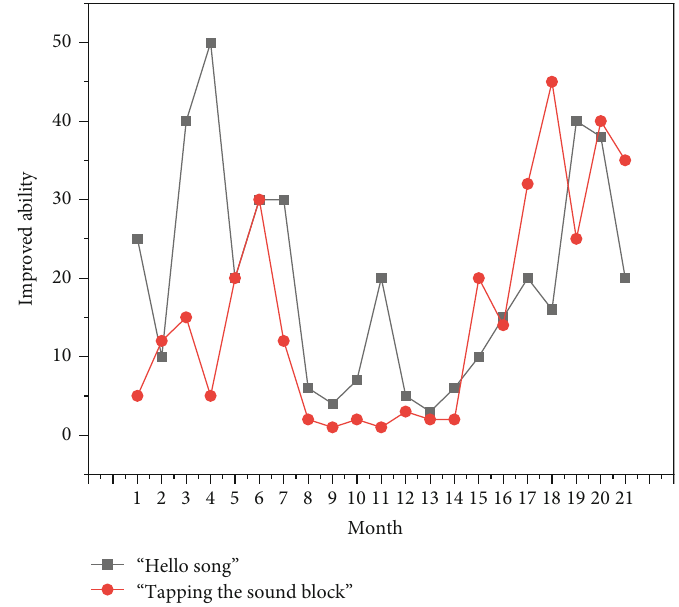
Figure 5: Improved ability to follow instructions in autism.